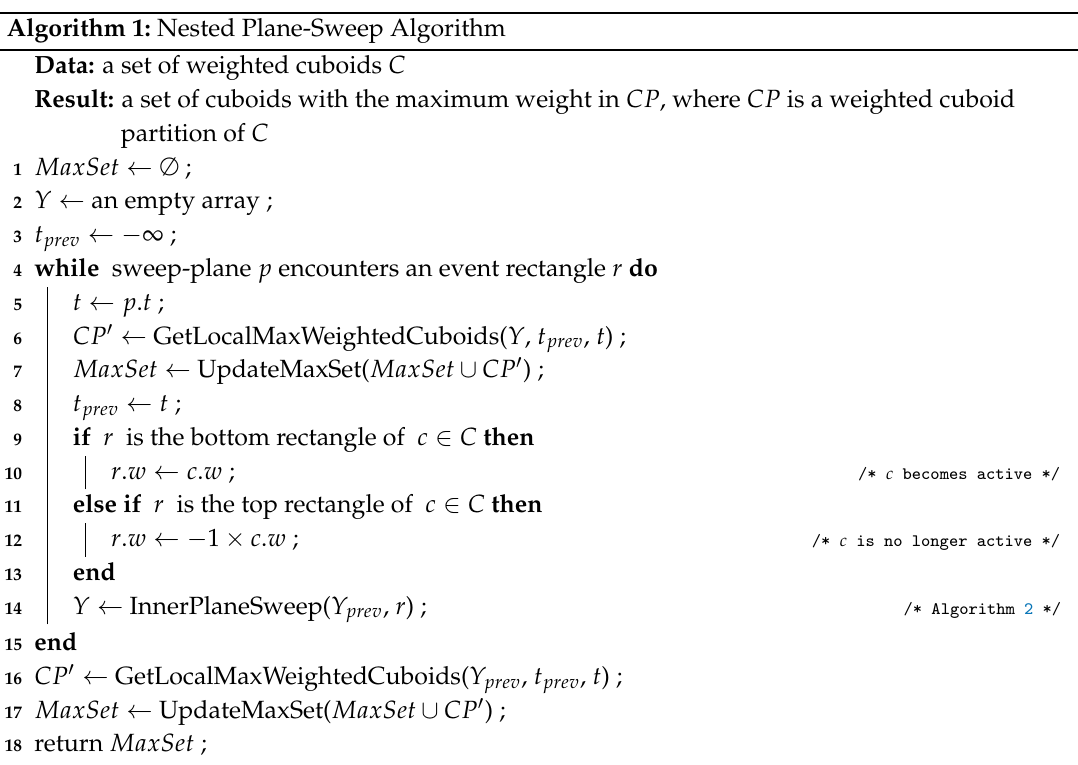
Algorithm 1: Nested Plane-Sweep Algorithm Data: a set of weighted cuboids